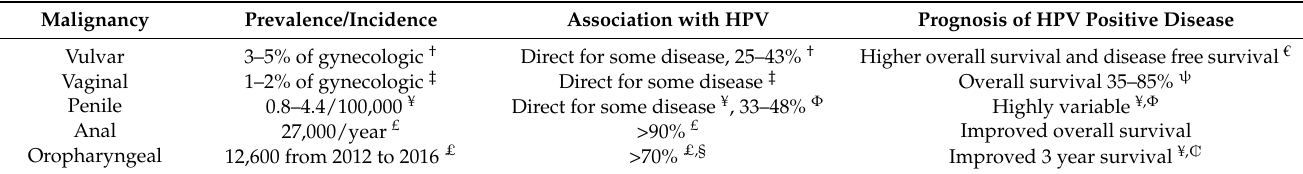
Table 1. Summary of non-cervical HPV related